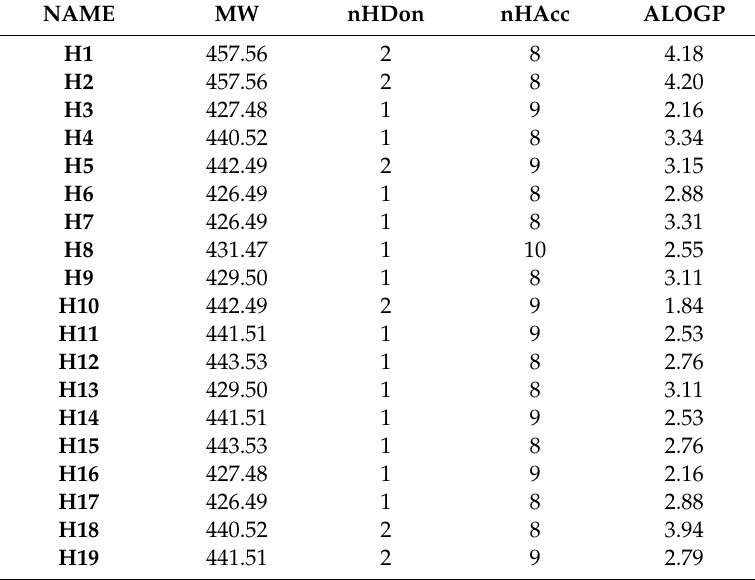
Table 7. Physicochemical properties of the virtual